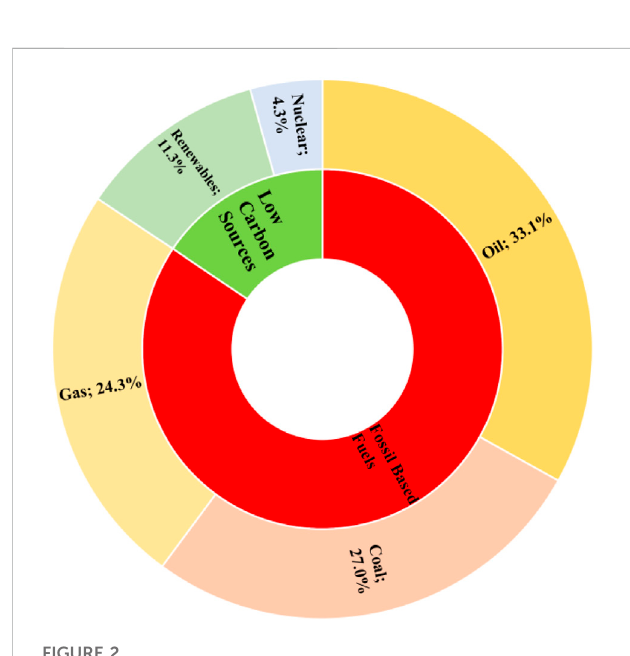
FIGURE 2 Breakdown of Global energy consumption in